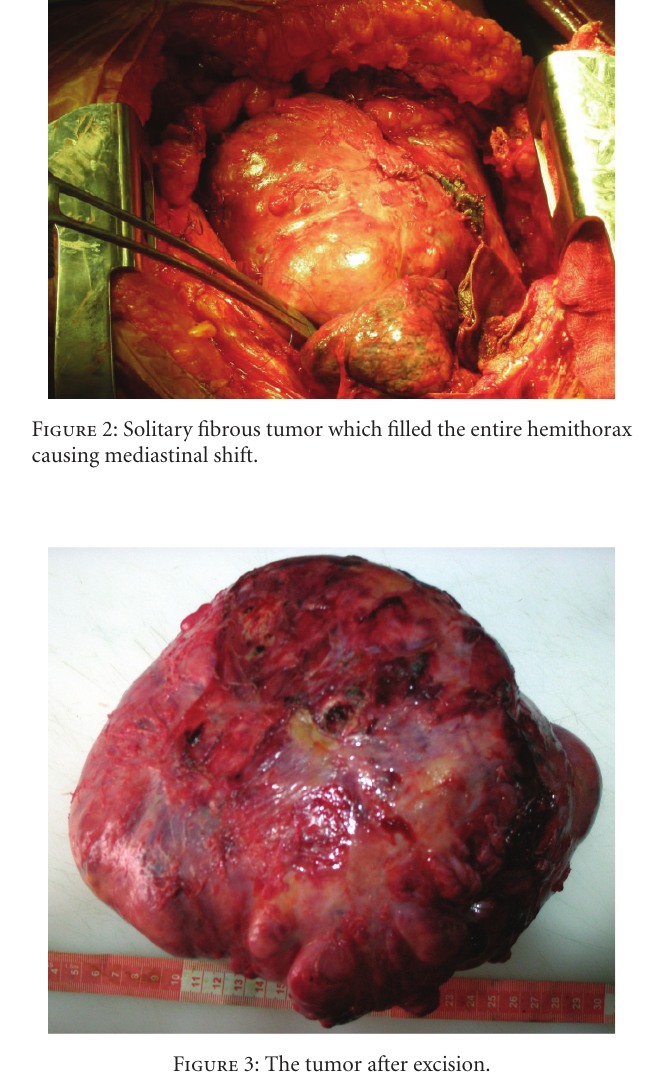
e ff usion, and right lung atelectasis. A 20 cm diameter mass that filled the whole right hemithorax extending from the